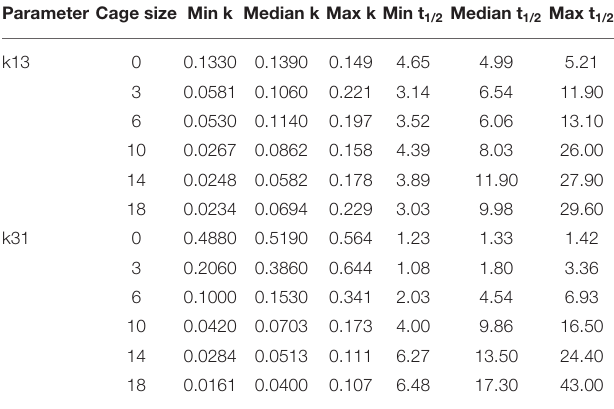
TABLE 6 | The difference in estimated marginal means (contrast) between the maximum concentration of carprofen in the respective cage sizes. Contrast Estimate Confidence